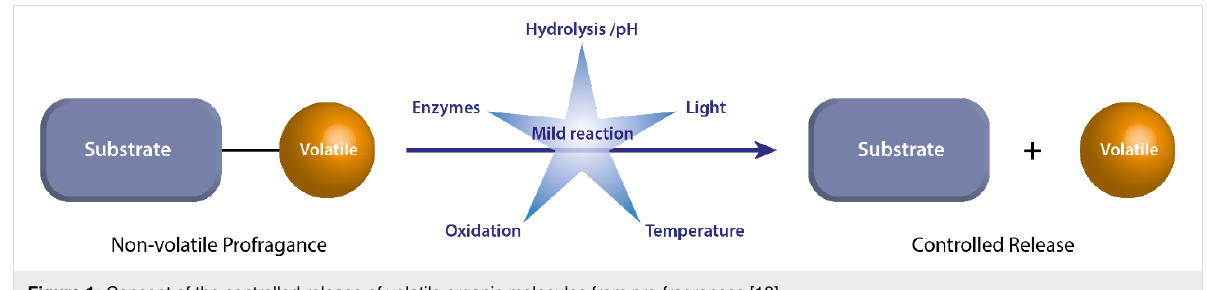
Figure 1: Concept of the controlled release of volatile organic molecules from pro-fragrances